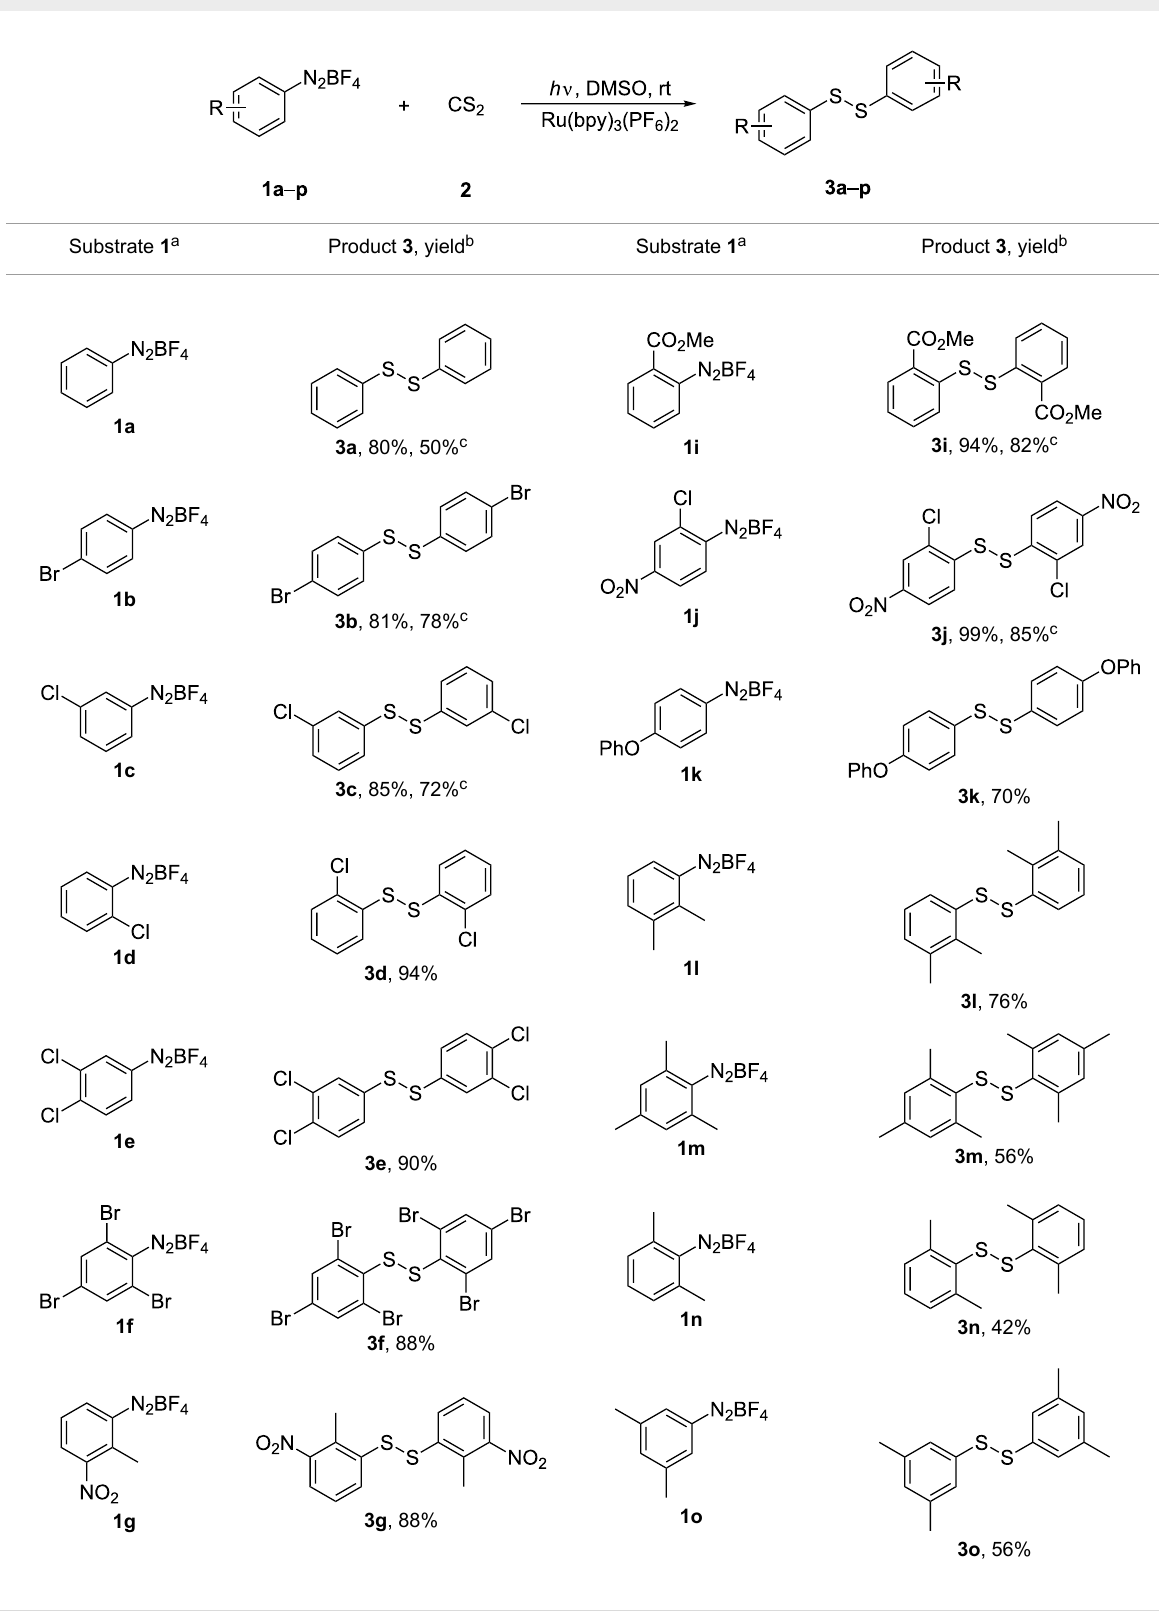
Table 4: Reaction scope of the visible light-mediated coupling of arenediazonium tetrafluoroborates 1 with CS 2 ( 2